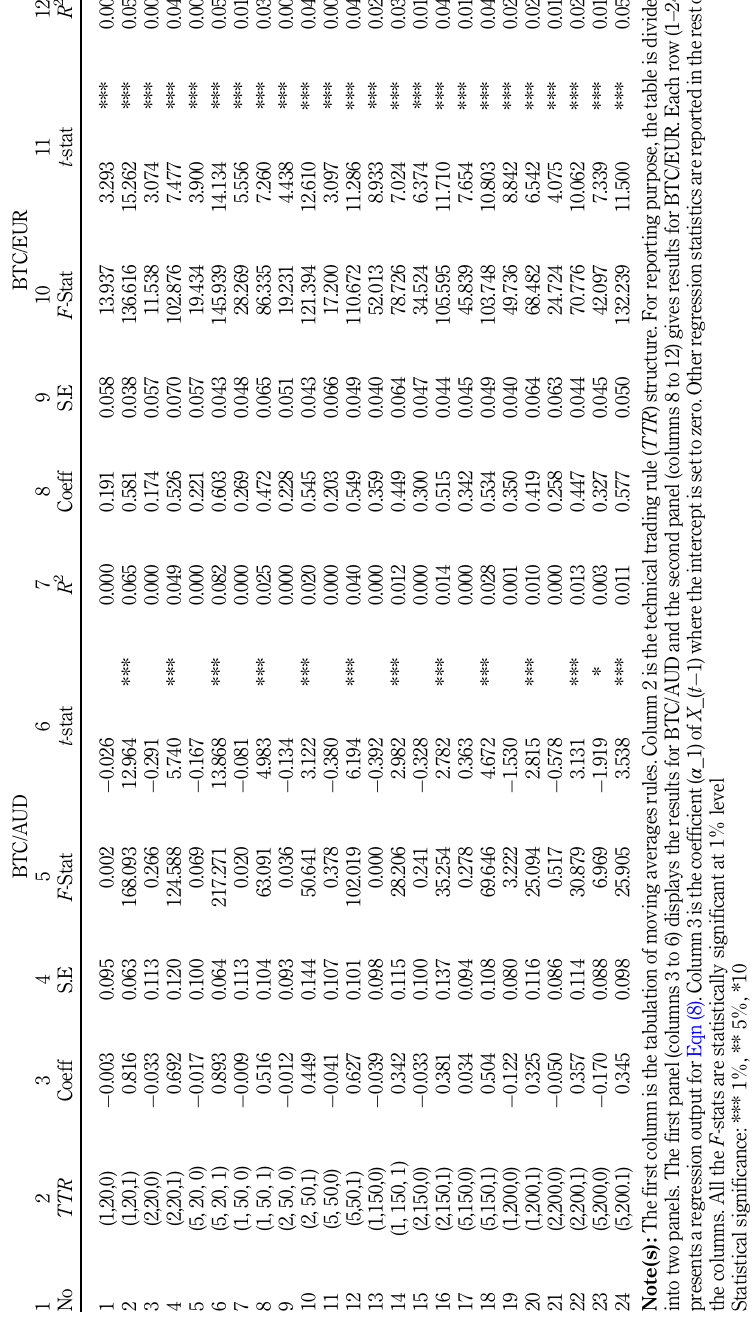
Table 6. Kho ’ s buy – sell mean- spread Test – BTC/ AUD and